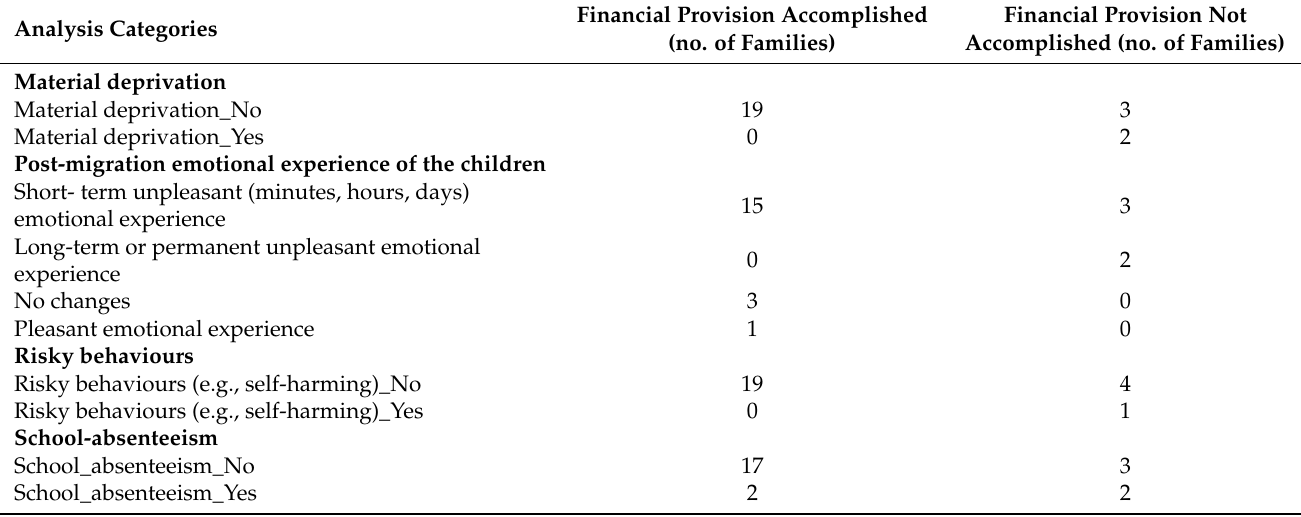
Table 4. The effects of weak financial provision on children